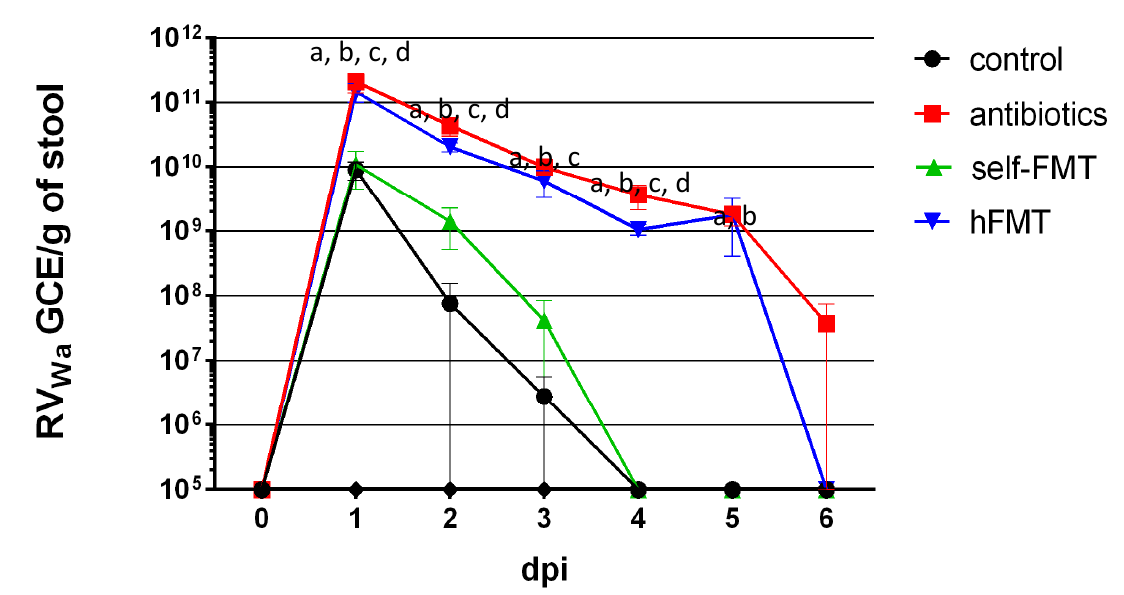
Figure 1. Rotavirus Wa shedding in mice stool. GCE/g of stool are presented for control mice, Ab-treated mice and mice subject to hFMT and self-FMT, respectively. The mice were followed for 6 days and euthanized on day 7. The letters indicate statistically significant differences ( p < 0.05) in the GCE between the groups (a, Ab vs. control; b, Ab vs. self-FMT; c, hFMT vs. control; d, hFMT vs. self-FMT). The error bars are standard deviations ( n = 5). The limit of detection was 10 5 GCE/g of stool. Ab, antibiotic; hFMT, human fecal microbiota transplantation; self-FMT, self-fecal microbiota transplantation.